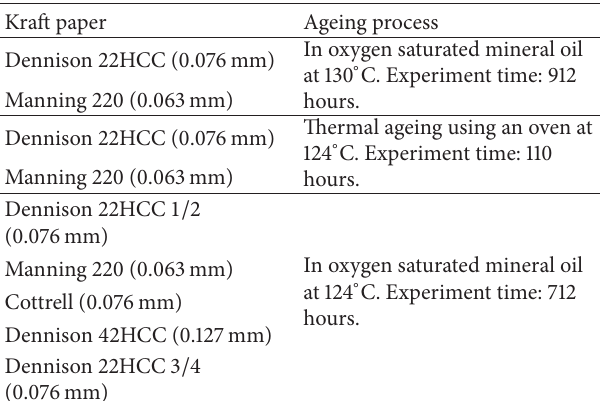
Table 1: Ageing processes for different types of kraft